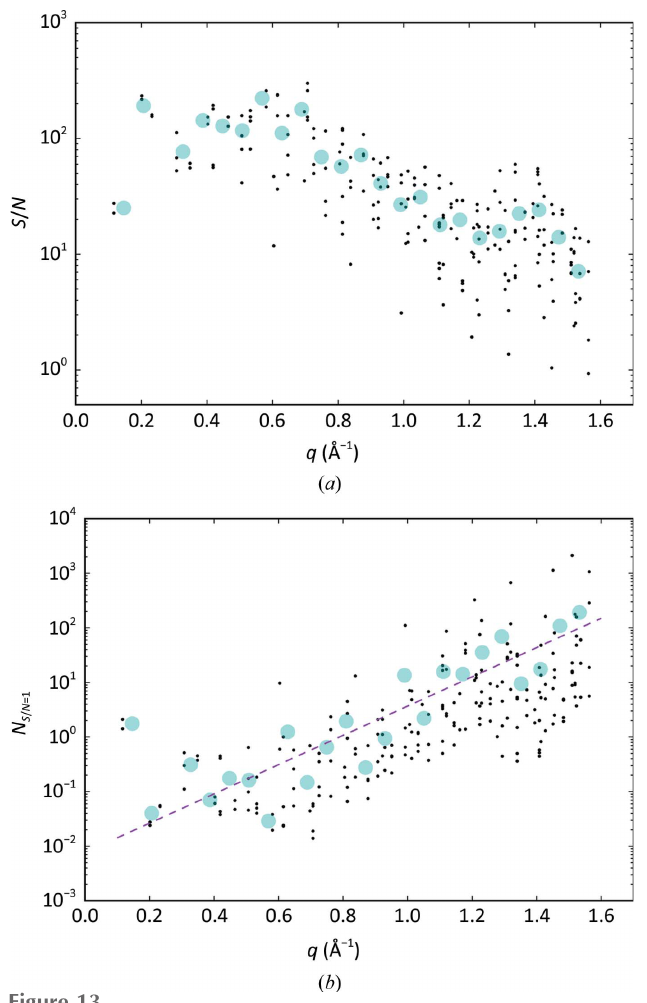
Figure 13 Signal to noise. ( a ) Signal-to-noise ratio S/N of the reflection intensity. ( b ) Estimated number of observations of each reflection to achieve a signal- to-noise value of unity ( N S/N = 1 ), with the dashed magenta line representing the best exponential fit. In both panels the values are shown as a function of the in-plane momentum transfer of the reflection. The large cyan dots are resolution-bin averages.